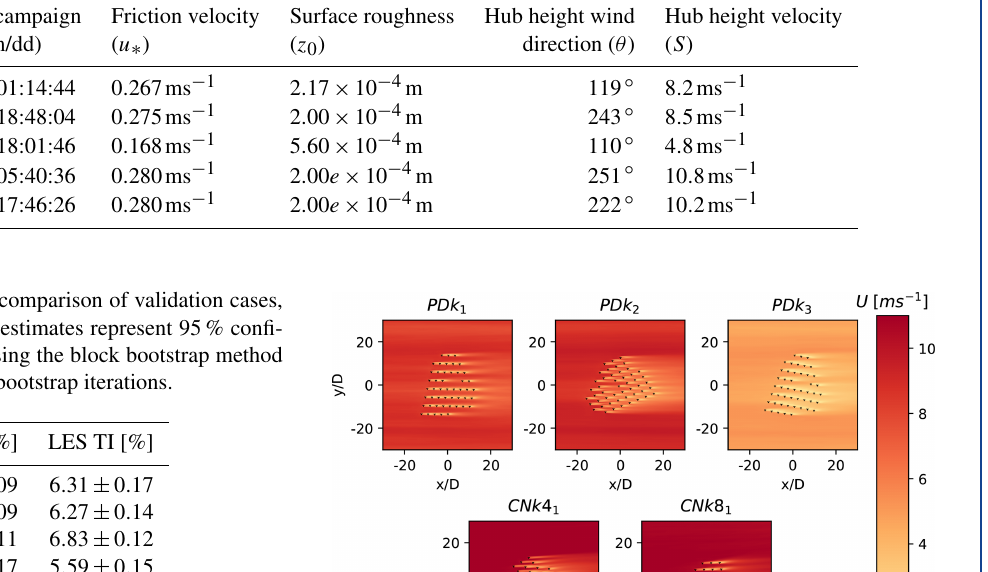
Table 2. Specifications of selected validation cases. Case